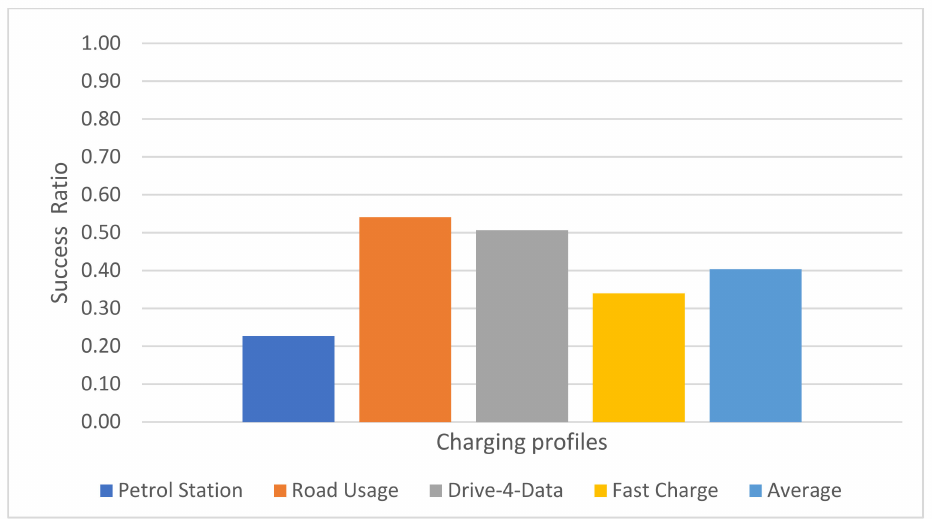
Figure 8. The success ratio of the grid-connected system with no storage as a function of the charging